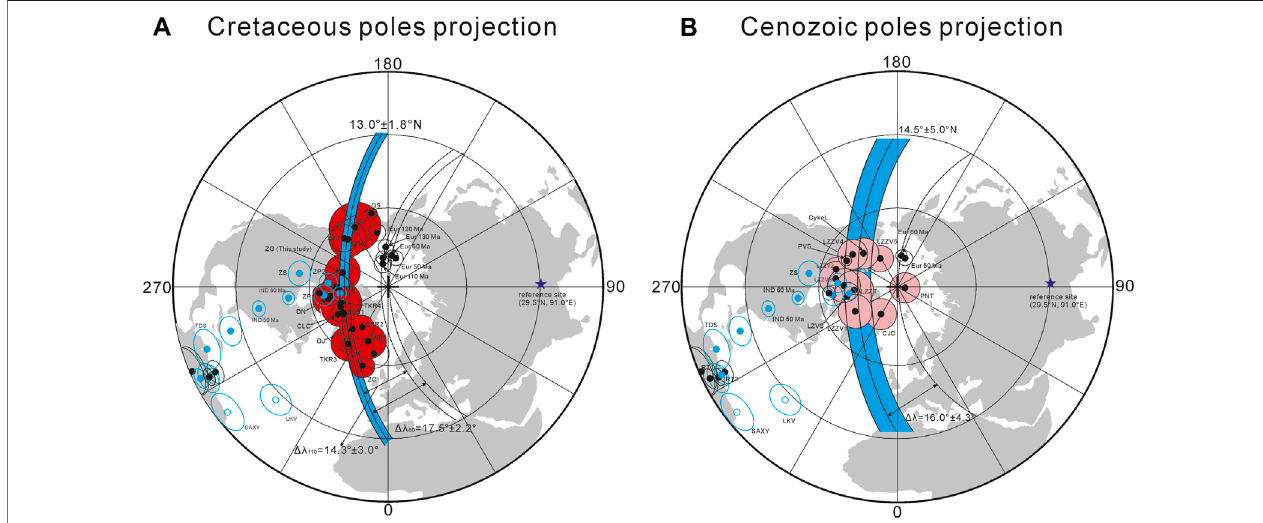
FIGURE 9 | Equal-area projections showing distributions of Cretaceous paleopoles (A) and Cenozoic paleopoles (B) of the Lhasa terrane and the Tethyan Himalayan terrane based on this study and previously published results, with corresponding 95% con fi dence ellipses. See Table 2 in the main text for values and cited references. The deep blue star indicates the reference site (29.5 ° N, 91.0 ° E), which represents the southernmost margin of Eurasia long before the India – Asia collision when calculating the paleolatitudes of the Lhasa and Tethyan Himalayan terranes in this study. The dashed lines represent the small circle running through the reference poles of Eurasia, India, and the Tethyan Himalayan terrane centered on the reference site. (A) Black dots with red- fi lled circles represent the selected Cretaceouspaleopolesthatwere fi ttedbythesmall-circlemethod(MardiaandGadsden,1977)andthecorresponding95%con fi dencecircles; (B) blackdotswithpink- fi lled circles represent the selected Cenozoic paleopoles that were fi tted by the small-circle method (Mardia and Gadsden, 1977) and corresponding 95% con fi dence circles. Blue dots with 95% con fi dence circles represent the reference poles of the Indian continent (from Torsvik et al., 2012) and the Tethyan Himalayan terrane. The light-blue strip areas with solid black line and dashed lines in (A,B) represent the small circles and corresponding 95% con fi dence limits passing through the selected Cretaceous and Cenozoic paleopoles centered on the reference site (29.5 ° N, 91.0 ° E) in this study, respectively. See the main text and Table 2 for